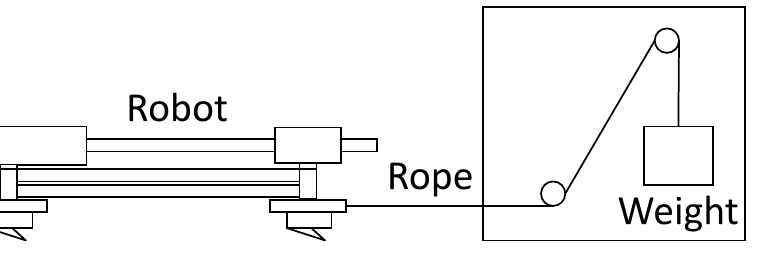
Figure 19. A schematic figure of the static frictional force measurement experiment. Table 4. The static frictional forces measured in both the forward and backward